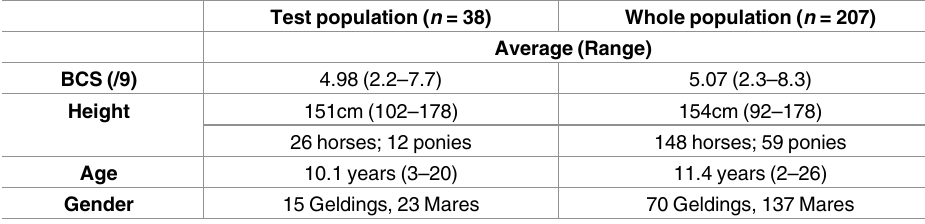
Table 1. Population of animals used in the current study as the test population used to develop the EQUIFAT scoring system( n = 38) and the population used to describe associations between EQUI- FAT scores and BCS ( n =